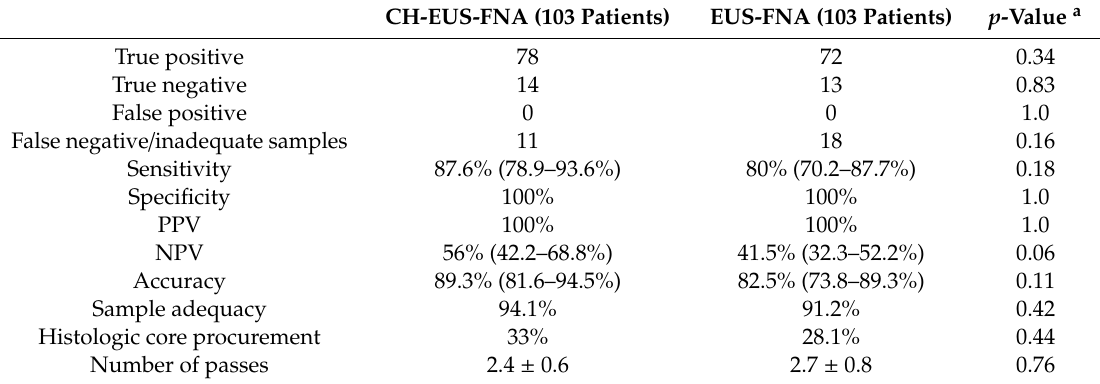
Table 2. Diagnostic performance of the two